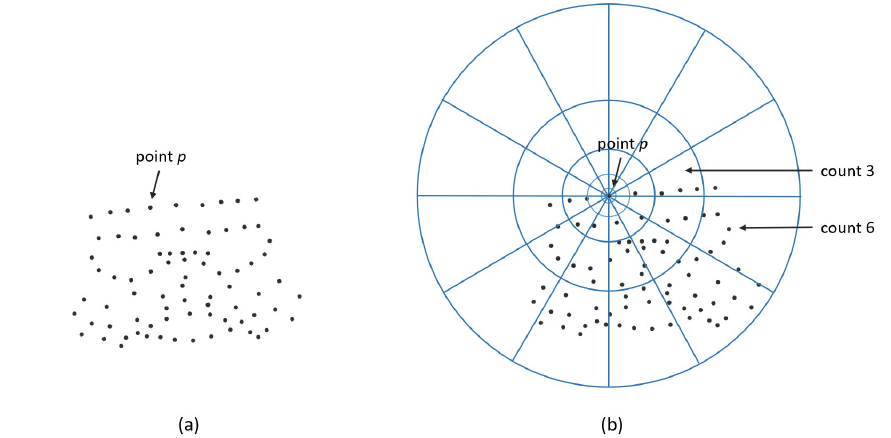
Figure 5. A scheme of representation of point sets using SC. ( a ) A point set of 78 points. ( b ) The SC feature diagram of point p